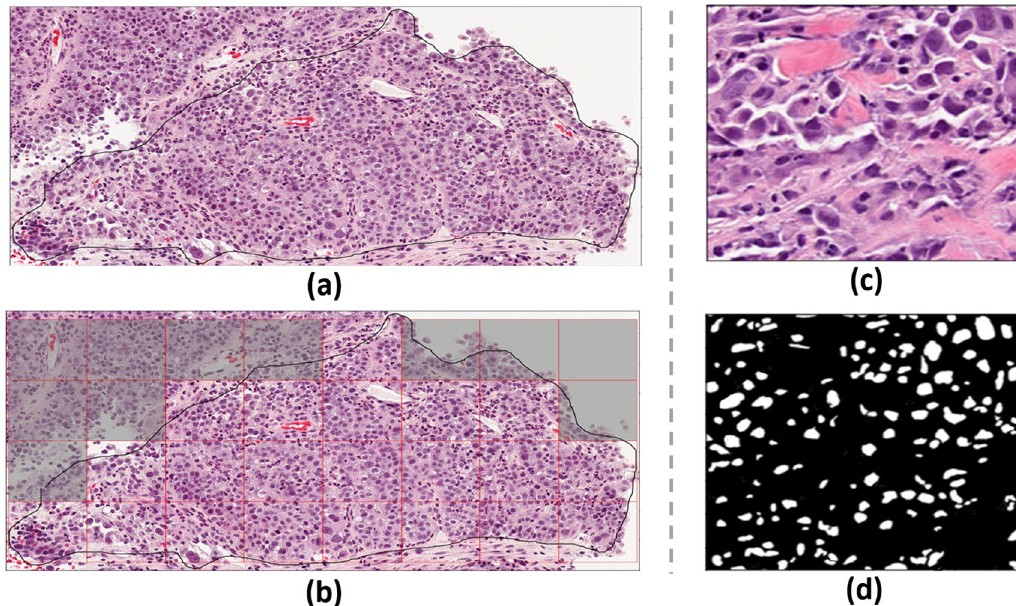
Figure 1. ( a ) An example of tumor bed annotation on a representative segment of the core on WSI (2188 × 4124 pixels), ( b ) the non-overlapping 768 × 768 pixel tiles extracted from the tumor region with the excluded tiles shaded (less than 50% tumor or more than 10% white background), ( c ) an extracted tile with 100% tumor tissue, and ( d ) the generated binary mask of the nuclei in the